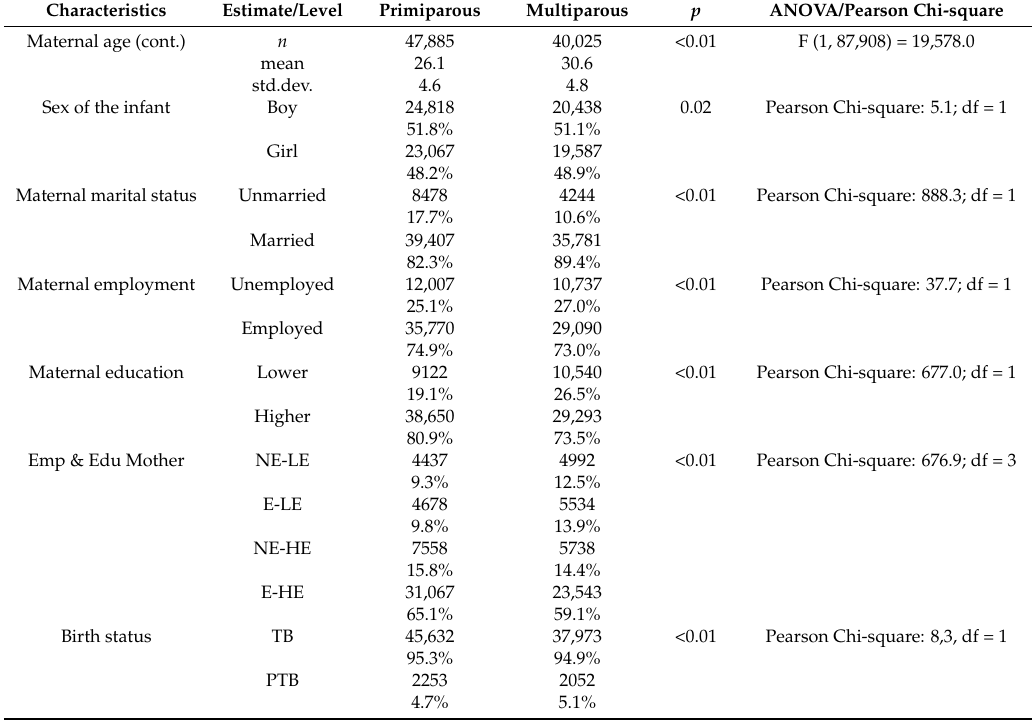
Table 2. Distribution of characteristics of singleton, live births stratified for parity. Characteristics